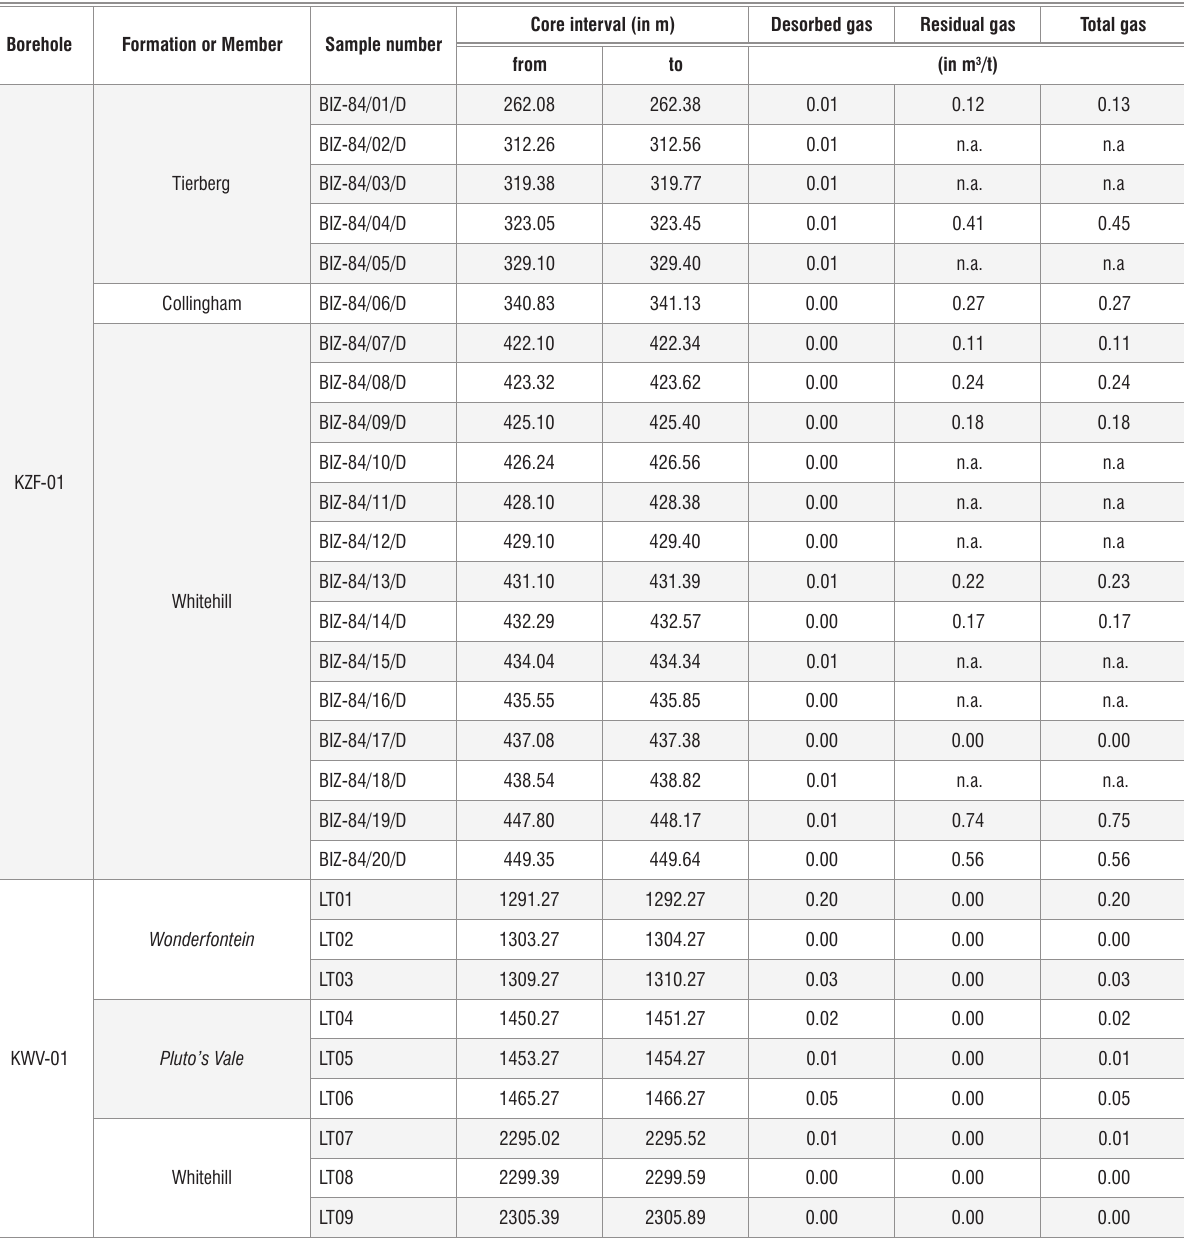
Table 1: Gas content of KZF-01 and KWV-01 core samples Borehole Formation or Member